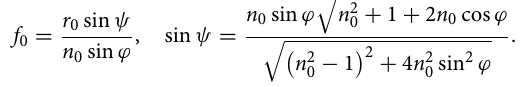
Figure 2. Beam-condensing and rotating principle in the horizontal direction. ( a ) Electrode pairs composed of upper and lower electrodes B k and a trace of guided light. Electrodes b 2k are generated from the combination of Al electrodes B k and ITO electrodes B k , and electrodes b 2k+1 are from Al electrodes B k and ITO electrodes B k+1 . In response to the voltages v 2k or v 2k+1 at electrodes b 2k or b 2k+1 , the ERIs of N 2k or N 2k+1 are aligned in the radial direction. The guided light deflects to the higher-index side at the intersection with the boundary of the diamond-shaped electrodes, as shown by the red arrow. ( b ) Examples of voltage waveforms applied to the B k electrodes. Amplitude distribution between the electrodes B k allows the beams to be collimated. Collimated beams can be rotated by applying a phase-shift signal to the neighbor electrodes. c. Relationships under a static condition between a voltage waveform and the response of the ERI to an azimuth angle φ. The waveform is represented by a collection of voltage elements v 2k and v 2k+1 which are applied to the electrodes b 2k and b 2k+1 . The curve of ERI traces a shape that is the inverse of waveform V B . ( d ) Perspective illustration of light radiated from the coupler C and a cross-sectional drawing of light refracted at the rod lens surface. When applied to the B k electrodes, the radiated light is focused on point F 1 and becomes a parallel beam after refraction at the side surface of the rod lens. ( e ) Ray-traced result for light that propagates in the guided layer and penetrates the RLE. This is an example for m = 5. In the range of φ = –36 to 36 degrees, the guide light is convergent and radiates from the coupler C. It becomes a parallel beam after focusing at point F 1 and passing through the rod lens. This situation is similar in the other angular ranges and five parallel beams are produced in total. ( f ) Necessary shape of the curve of the ERI